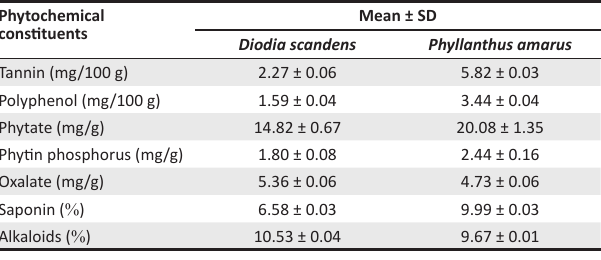
TABLE 4: Quantitative analysis on the phytochemical constituents of Diodia scandens and Phyllanthus amarus . Phytochemical Mean ± SD constituents Diodia scandens Phyllanthus